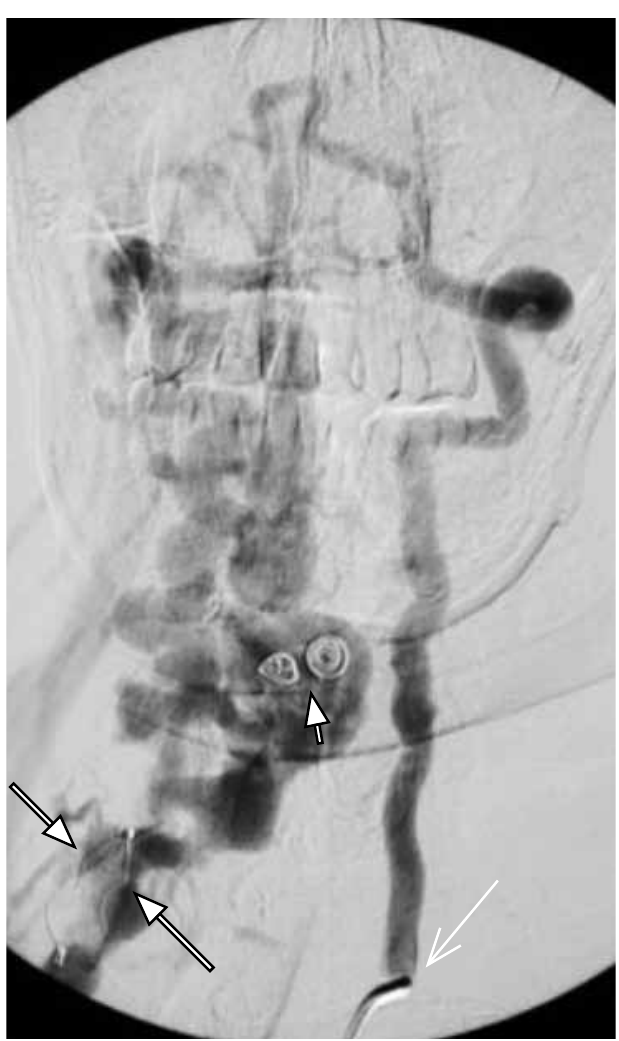
Fig. 5. DSA post embolisation with the catheter tip in left (contra-lateral) vertebral artery (open arrow) demonstrates persistence of the spinal AVF, which is fed by the contra-lateral vertebral artery. Note the Amplatzer vascular plug in the proximal right vertebral artery (filled arrows) and the 2 IMWCE 35-6-6 coils (arrowhead) within the spinal